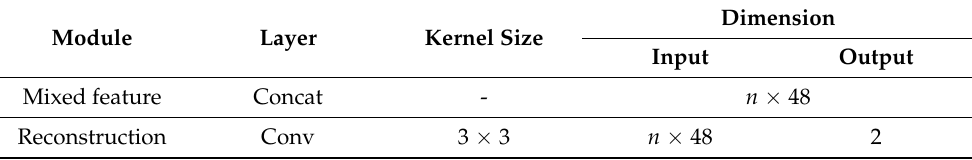
Table 2. The configurations of the mixed feature module and reconstruction